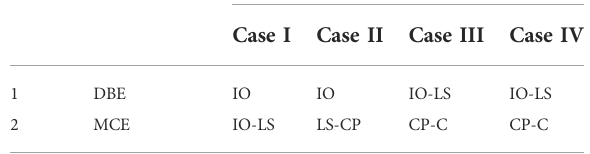
TABLE 7 Variation in performance